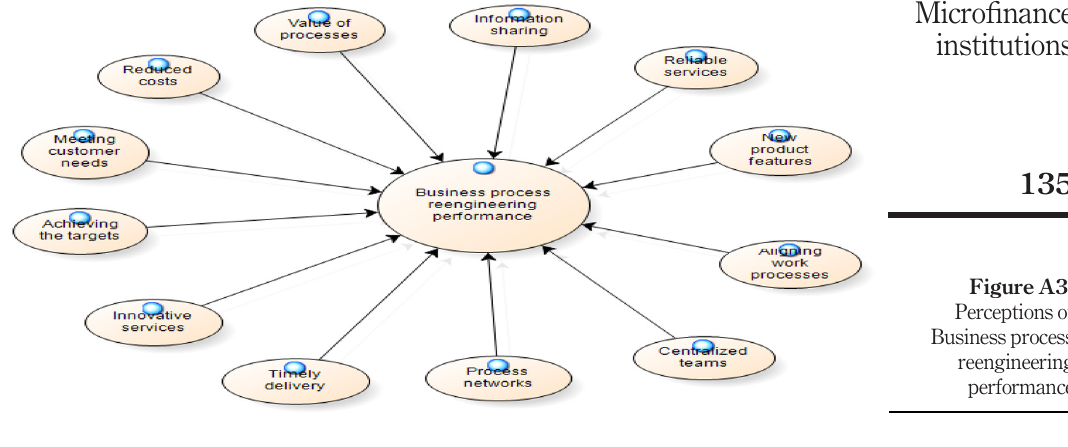
Figure A3. Perceptions